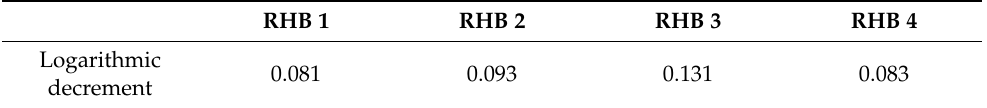
Table 2. Logarithmic decrement